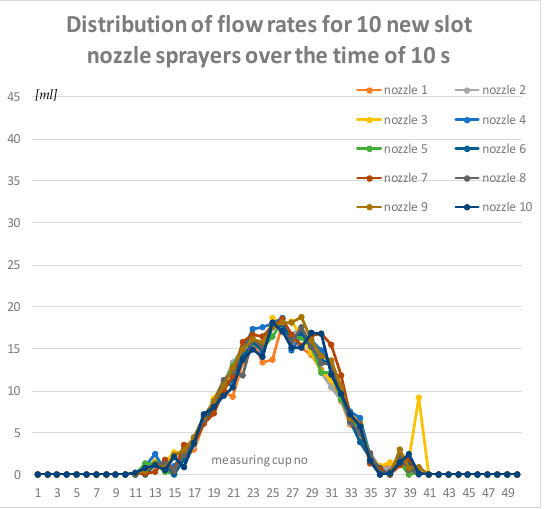
Figure 4. Distribution in 50 measuring cups of flow rates over the time of 10 s for 10 new flat fan nozzles from group C.